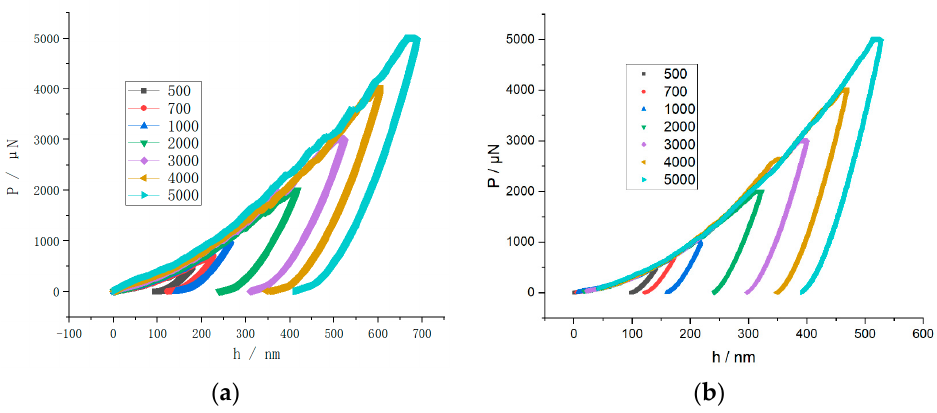
Figure 2. Quasi-static load–displacement curve for DNTF ( a ) and CL-20 ( b ). The curves obtained exhibited similarity to the theory curve above. With the increase in loading, the maximum depth of the indenter ( h max ) and the final indentation depth ( h f ) increase continuously gradually. During the loading, the displacement on both crystals showed a sudden increase, which was mainly caused by internal microdefects such as microcracks, micropores, etc. When the contact surface of the indenter is close to the de- fect, the elasticity and hardness of the local material will decrease sharply, resulting in the